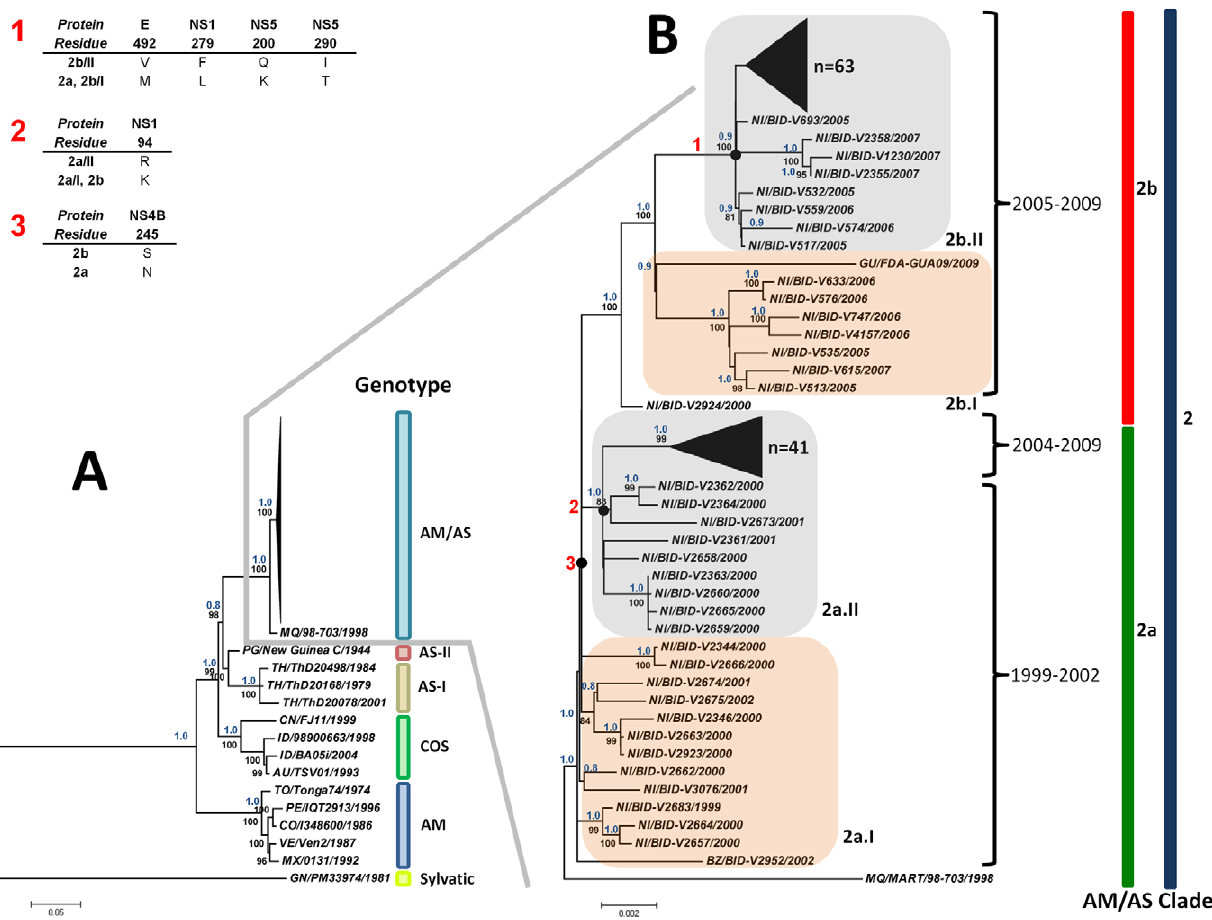
Figure 1. Maximum Likelihood (ML) consensus of the open reading frame (ORF) of DENV-2. A) Consensus ML tree constructed with the ORF of representative sequences of all DENV-2 genotypes. DENV-2 genotypes (Sylvatic, American, Asian I and II, Cosmopolitan and American/Asian) are identified. Strains from the American/Asian genotype are shown collapsed. B) Detail of A showing the cluster of the American/Asian genotype constituted by 141 Nicaraguan strains, and one strain each from Guatemala, Belize and Martinique. Names of each clade and sub-clade are shown, as well as the years of circulation for the sub-clades. Similar sequences at the top of clades 2a and 2b are shown collapsed. Groups I and II within sub- clades 2a and 2b are shown highlighted in a gray and orange shadows. Consensus trees were generated by ML and Bayesian methods. Bootstrap support values of 1,000 replicates using the ML model of evolution and Bayesian posterior probability values are shown in blue above node. Only bootstrapping values . 80 are shown. Branch lengths are proportional to the bar and represent the number of nucleotide substitutions between the analyzed viruses. Amino acid changes found in different DENV-2 proteins associated with the different sub-clades are shown and identified in the tree with numbers (1–3) in